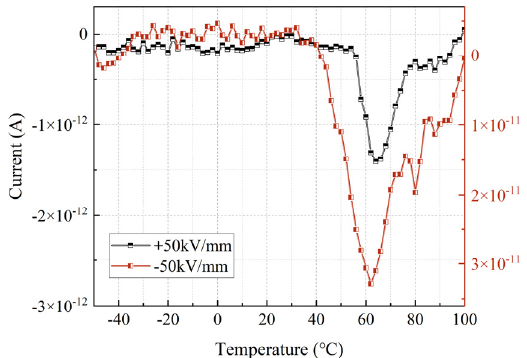
Figure 3. TSDC curves of PP at different polarization electric fields.